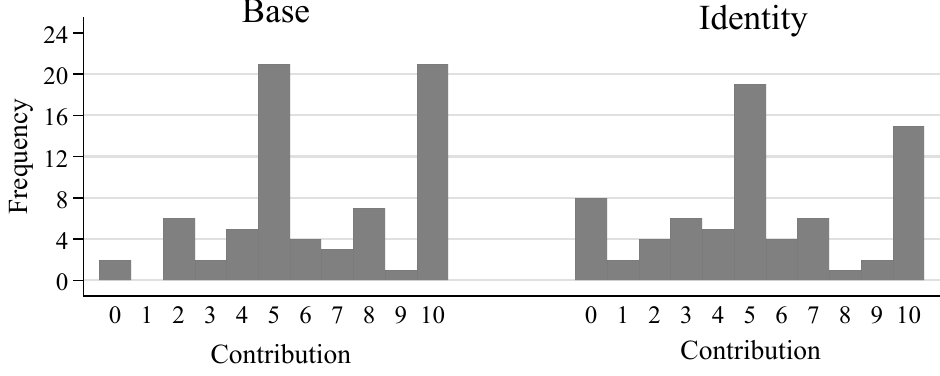
Figure 2. Distribution of Contribution in Round 1.